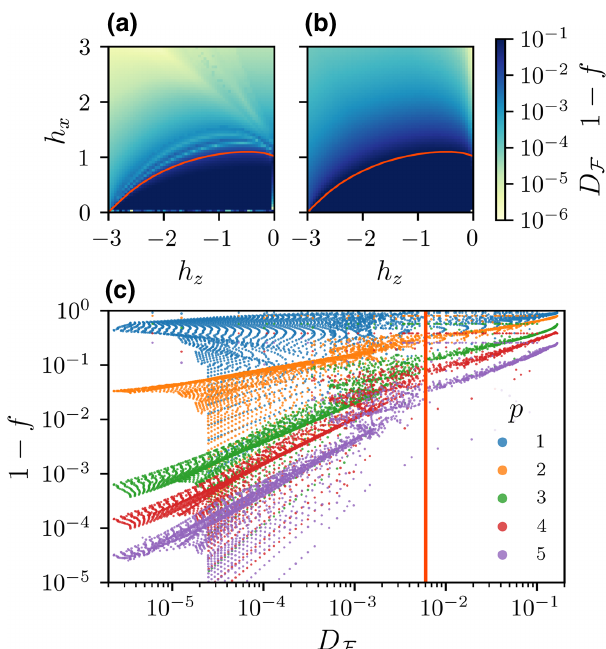
FIG. 6. Top row: interaction distance for the three-spin Ising model in Eq. (A1) as a function of fields h z and h x (a) and the infidelity 1 − f of the QAOA protocol (b). The QAOA protocol is based on Eqs. (11), (12), (A3). All data are for system size N = 9 using PBCs. The red line is the critical line in the three- spin Ising model according to Ref. [68] Bottom row: scatter plot of D F against 1 − f for the three-spin Ising model, system size N = 9, and different values of p indicated in the legend. The ver- tical red line, drawn heuristically, separates the data belonging to the phases above and below the critical line (respectively to the left and right of the vertical line).